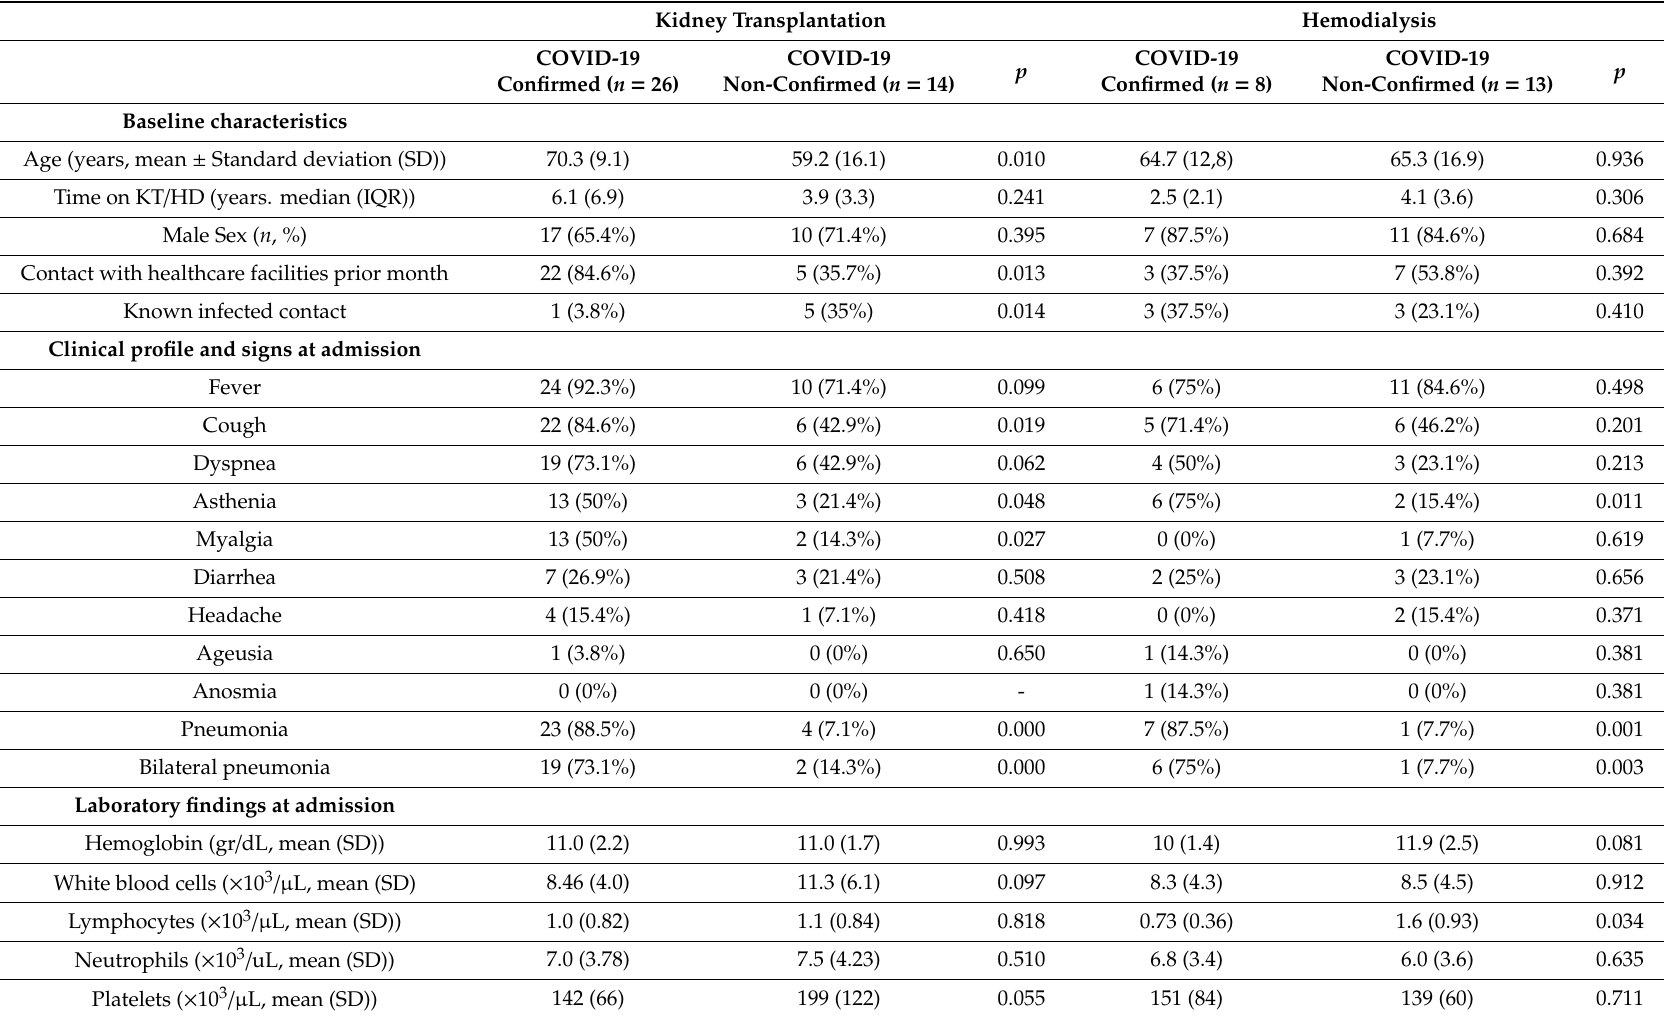
Table 5. Confirmed and non-confirmed COVID-19 in kidney transplant recipients and hemodialysis